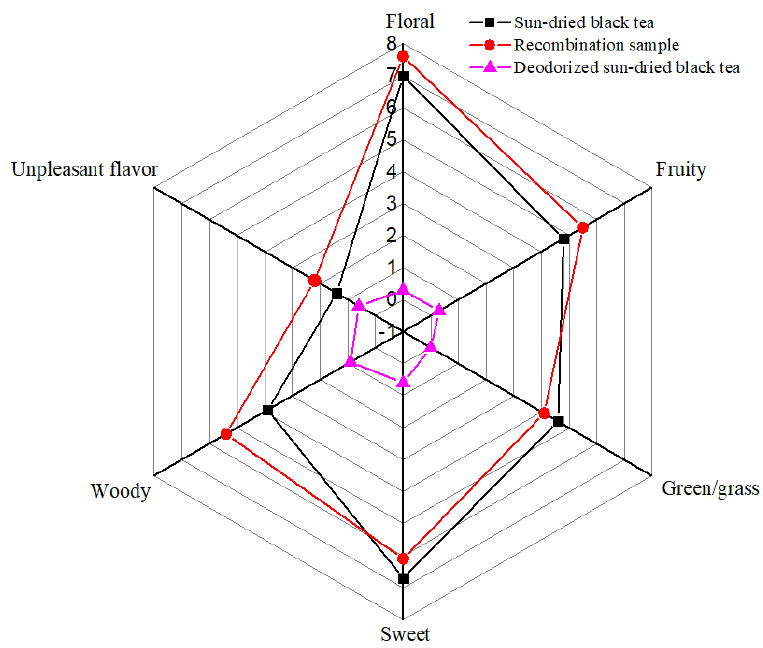
Figure 2. Aroma profile of the recombination sample and the sun-dried black tea. Table 3. The results of the omission